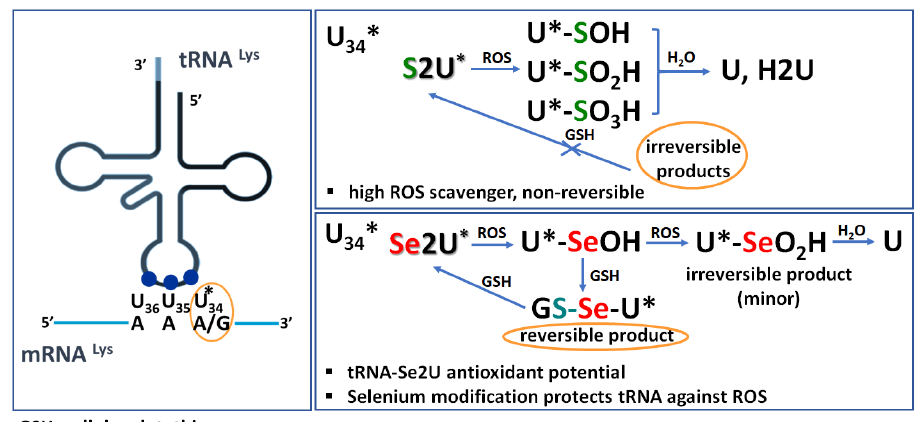
Figure 12. Schematic difference between sulfur- and selenium-modified uridines (R5S2U and R5Se2U) found in wobble position of transfer RNAs in the presence of redox-reactive agents (reactive oxygen species ROS and reducing agents as glutathione).